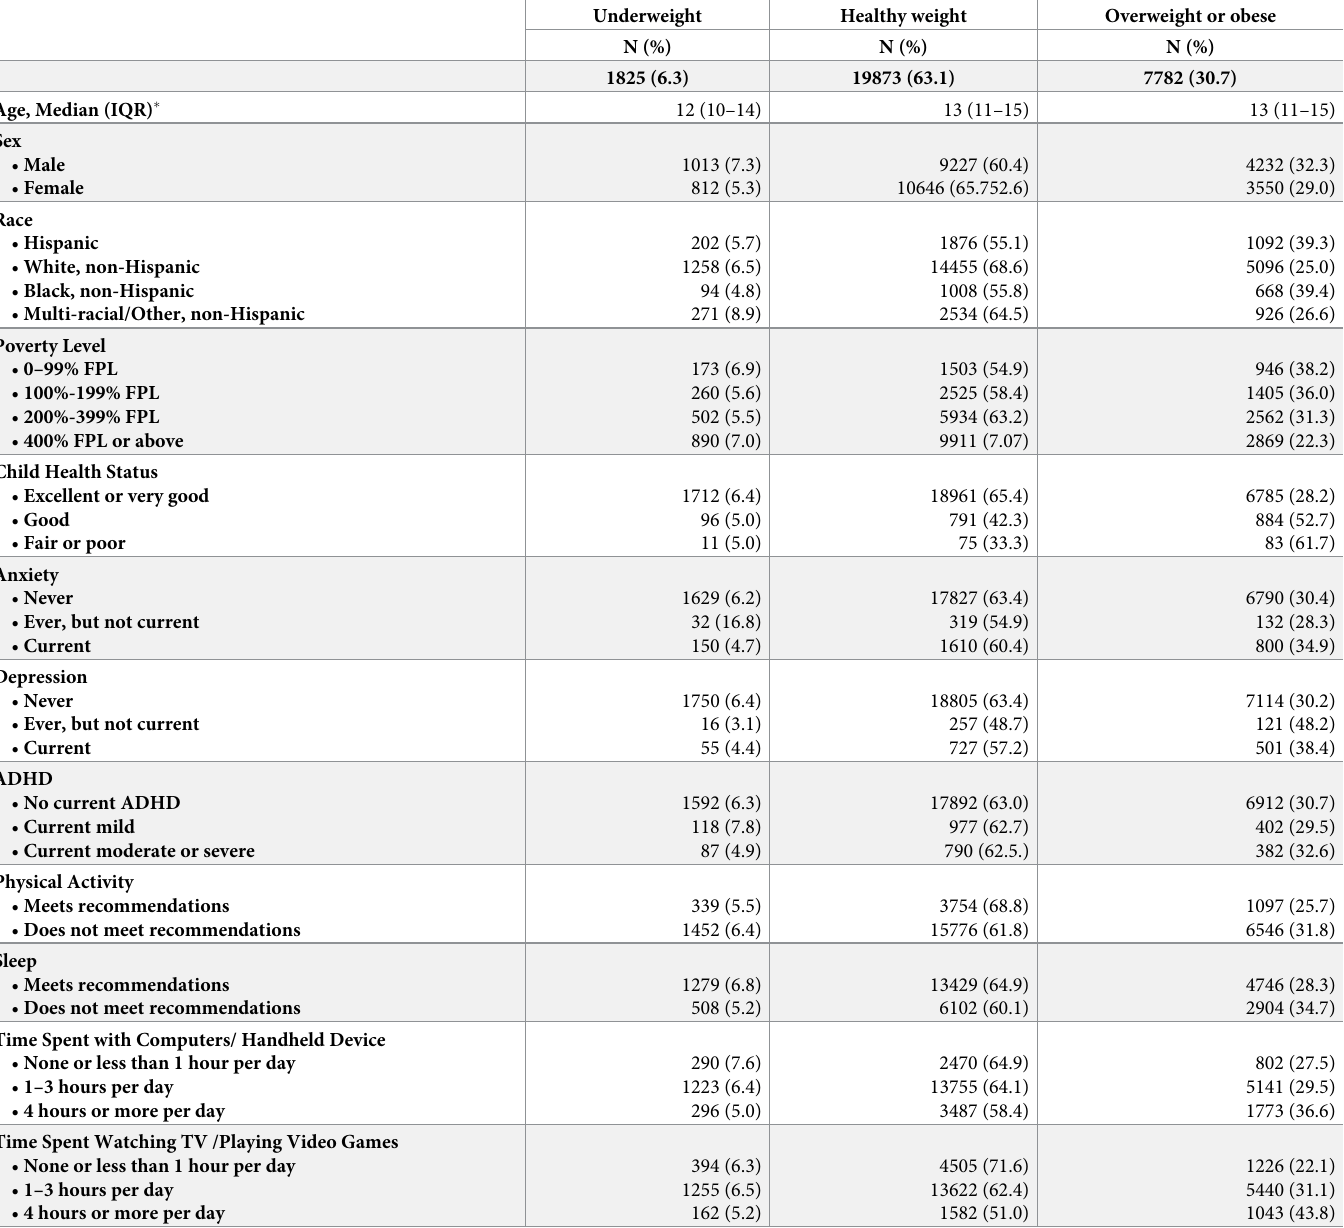
Table 1. Characteristics of adolescent participants in the National Survey of Children’s